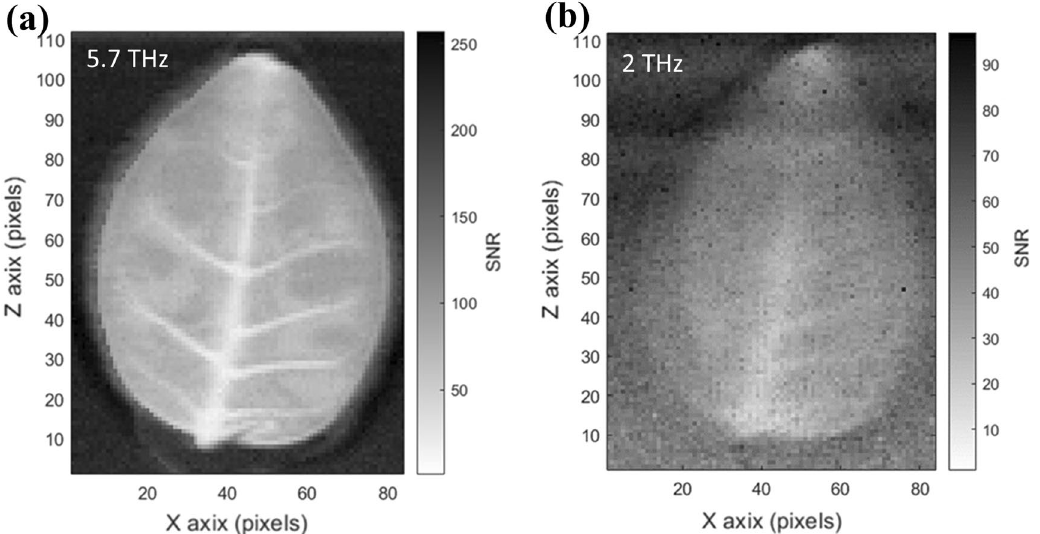
Figure 10. ( a ) SNR image of the leaf at 5.7 THz. Owing to the high material absorption, the leaf edge has relatively good contrast in the image. ( b ) SNR image of the leaf at 2 THz. Although the 2-THz source has a lower peak power, the best SNR in the image pixel is almost 20